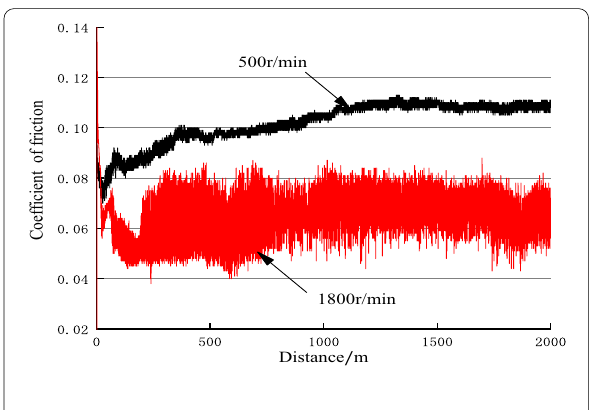
Figure 8 Friction coefficient under different speed